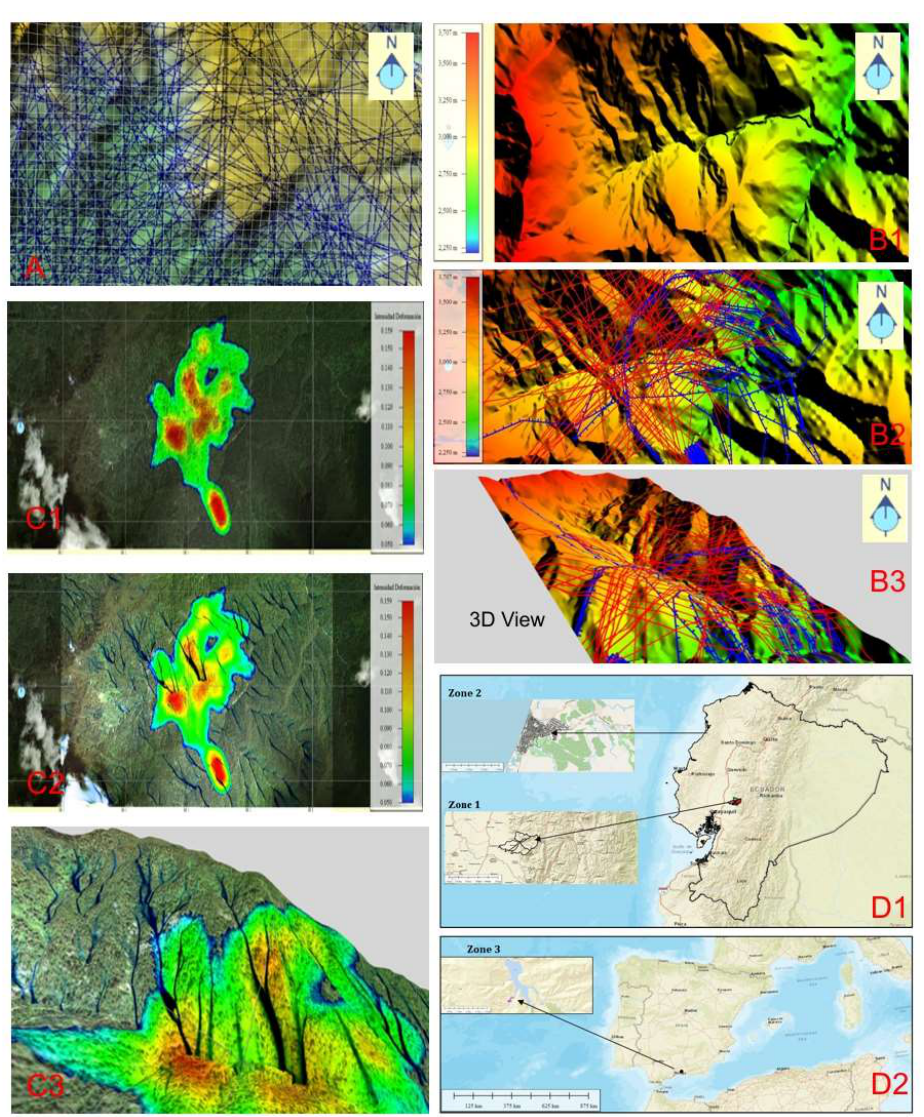
Figure 6. ( A ) Phase 4: Tracing of curvature vectors created by the trace of intermediate meshes of change in slope and inflection that indicates concavity or convexity surfaces. ( B1 ) Final state of active surface deformation of a region. ( B2 and B3 ) with internal mass flows determined by the intersection of a set of morphological break lines (blue lines-morphological rupture and red lines-runoff flows) that define critical points and regions of susceptibility to movement. ( C ) Formation of the Morphological Sliding Plates in a function of flow lines and rupture lines. ( C1 ) Sliding mantles without internal flow, ( C2 ) sliding mantles with internal flows, and ( C3 ) 3D model with sliding mantles obtained. ( D ) Study areas. Zone 1 ( D1 ): Located between the towns of El Cadial, Chilcaloma, and Angas, in the province of Bolivar, Ecuador. Zone 2 ( D1 ): Town of Pedernales, province of Manabí, Ecuador. Zone 3 ( D2 ): Arenas Del Rey in Granada, Andalusia, Spain.